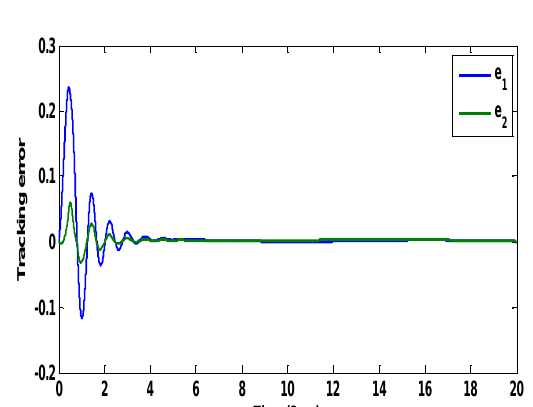
Figure 11. Motor voltages under disturbance.